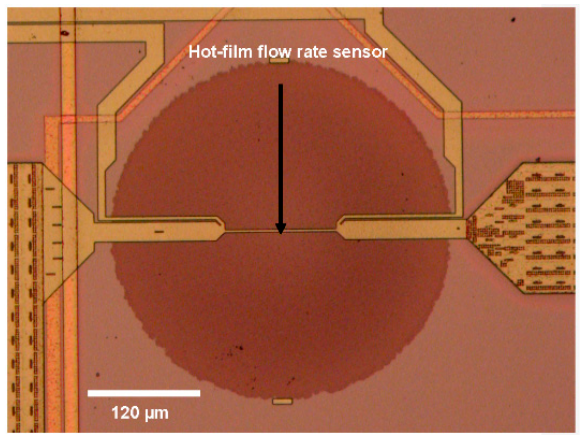
Figure 7. Close up view of hot film flow rate sensor on the multi-sensor SOI CMOS MEMS chip. The aluminium-based sensor hot film is 120 µm long and 2 µm wide. The diameter of the silicon oxide membrane is 360 µm.